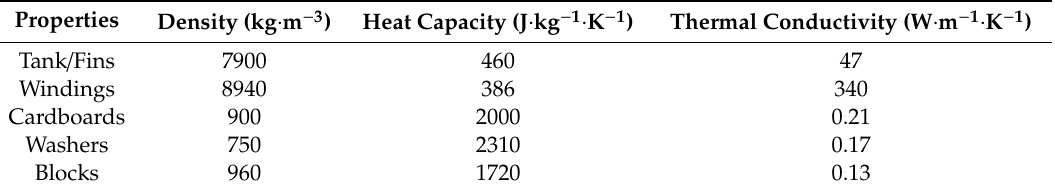
Table 3. Corresponding parameters for the simulation.